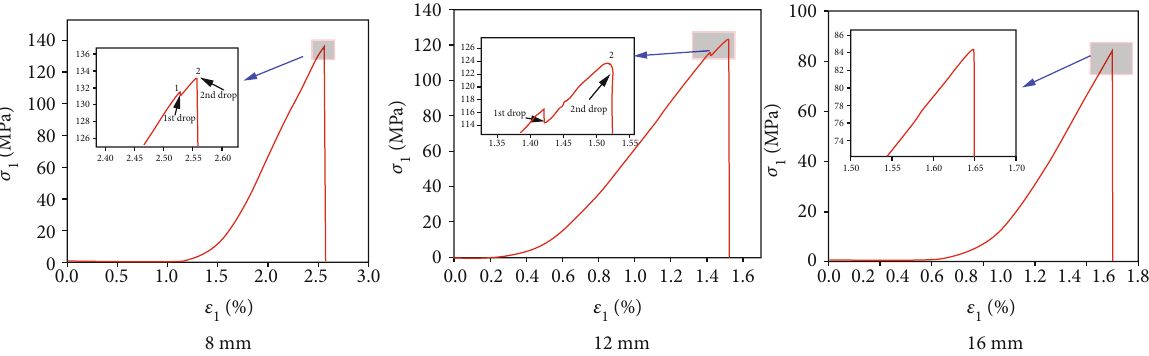
Figure 4: Stress-strain curve of culvert prefabricated drilled specimen under uniaxial compression.